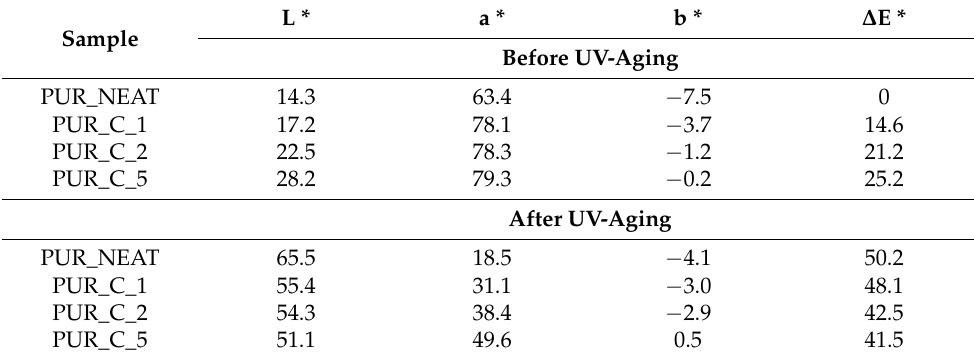
Table 2. Color parameters of PUR composites measured before and after the UV-aging.